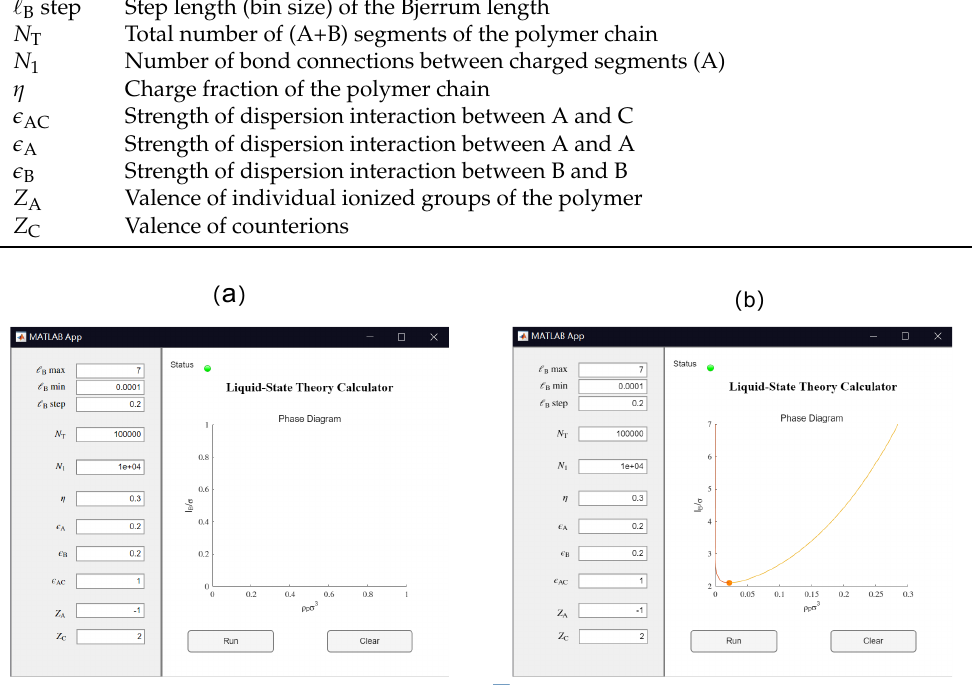
Figure 4. Illustration of the GUI App of a Liquid State Theory Calculator based on MATLAB (version R2022a): ( a ) after setting values for the parameters but before clicking “Run” and ( b ) the resulting binodal curve and critical point (shown by the filled circle). Here, the polymer solution is in a single phase below the binodal curve and is separated into two phases above the binodal curve. The App generates a Matlab “.mat” file containing the numerical results labeled by the parameters for further